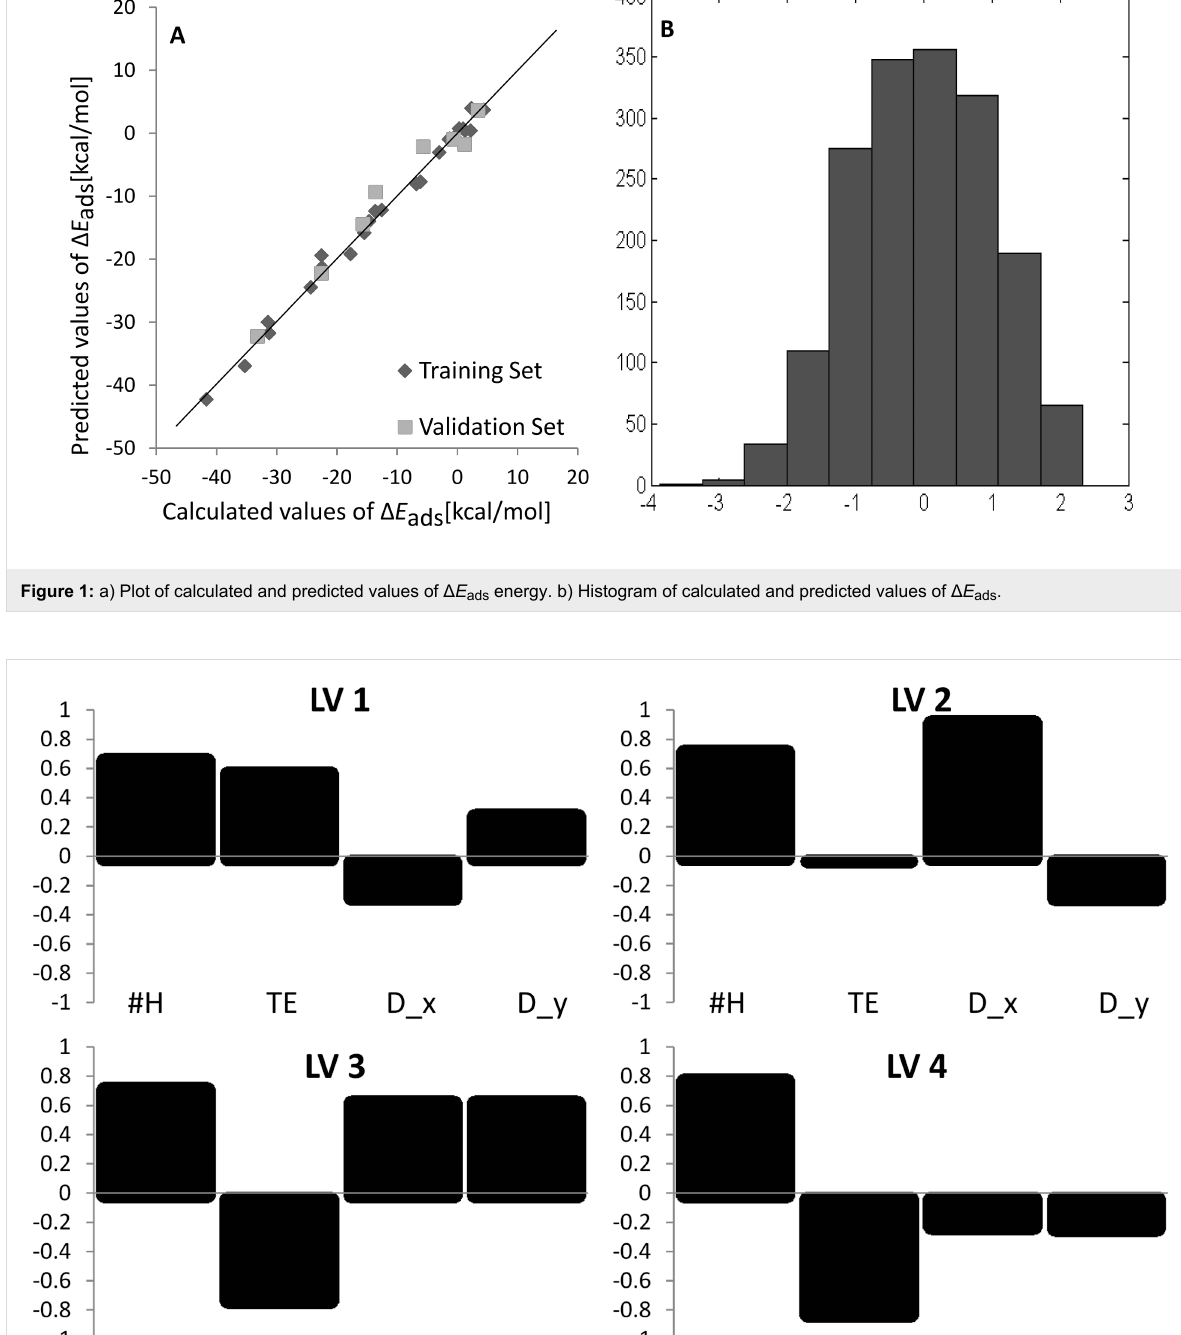
tuted in positions 2,3,7,8 and filled with hydrogen atoms in po- sitions 1,4,6,9 will have the highest values of LV2. Because of the differences in the electro-negativity of bromine and chlo-